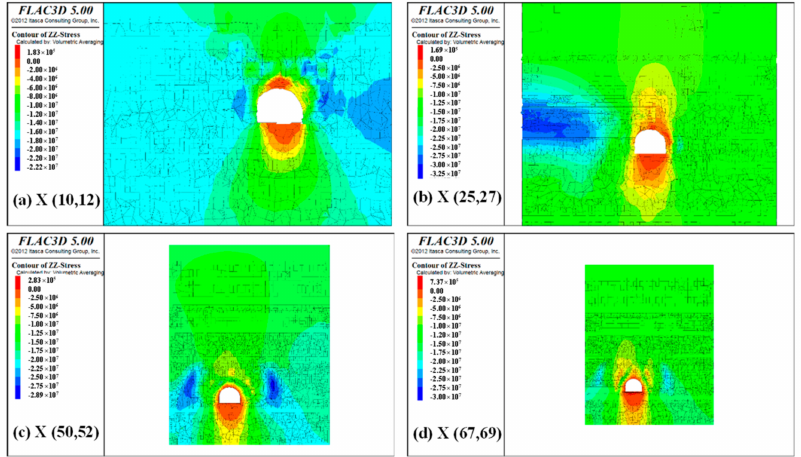
Figure 9. Z − direction stress distribution of the four monitoring areas without excavation disturbance.